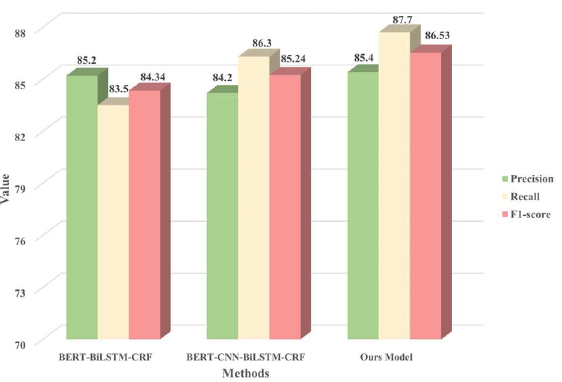
Figure 5. Performance of the model in this study compared with the two baseline models.